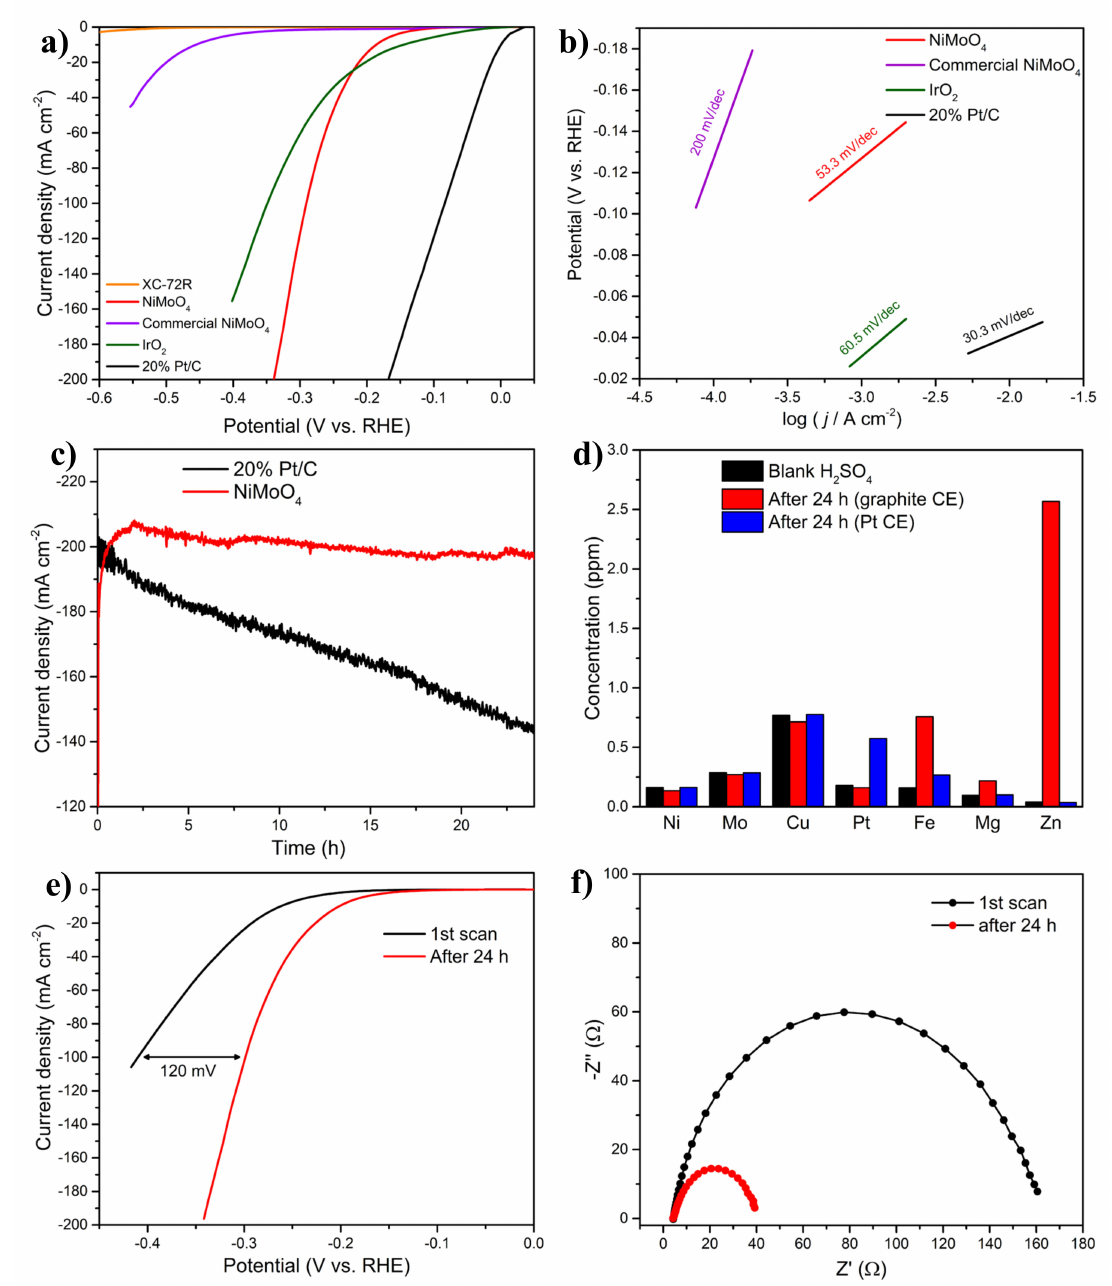
Figure 5. ( a ) Polarization curves of the best-performing NiMo-oxide/CB/Nafion electrocatalyst layer (denoted by NiMoO 4 and exhibited the following specifications; Nafion (dry weight) loading: 23%, electrocatalyst loading: 0.354 mg cm − 2 , CB loading: 38%, CB type: XC-72R, calcination temperature: 500 ◦ C, calcination time: 6 h, Ni/Mo: 1, precursor solution’s pH: 4.57, ϕ : 1) and other benchmarks, recorded in 0.5 M H 2 SO 4 at a scan rate of 1 mV s − 1 and corrected for ohmic ( iR ) drop ( b ) Tafel regions of the LSV plots in ( a ). ( c ) Long-term stability test of the NiMo-oxide/CB/Nafion electrocatalyst layer (denoted by NiMoO 4 with the same specifications as those mentioned in ( a )) and 20 wt.% Pt/C conducted at − 0.58 V and − 0.33 V, respectively. ( d ) ICP-MS analysis of the blank H 2 SO 4 electrolyte, and the electrolyte collected after the long-term stability test presented in ( c ) using a graphite rod and a Pt coiled wire as counter electrodes (CE). ( e ) LSV of the electrocatalyst layer before and after the long-term test presented in ( c ). ( f ) Nyquist plot of the electrocatalyst layer before and after the long-term test presented in ( c ), conducted at an overpotential of − 0.23